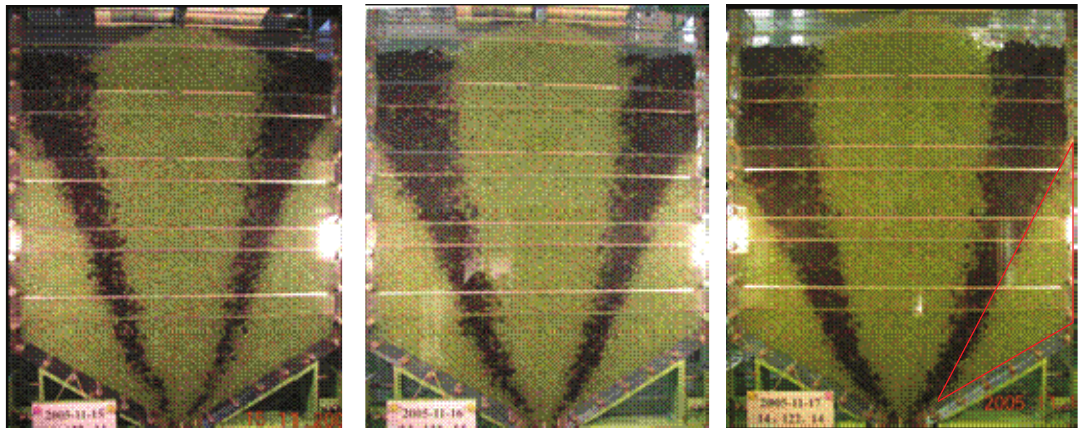
Figure 1: Sketch of the stagnant zone of different time with the side area method in